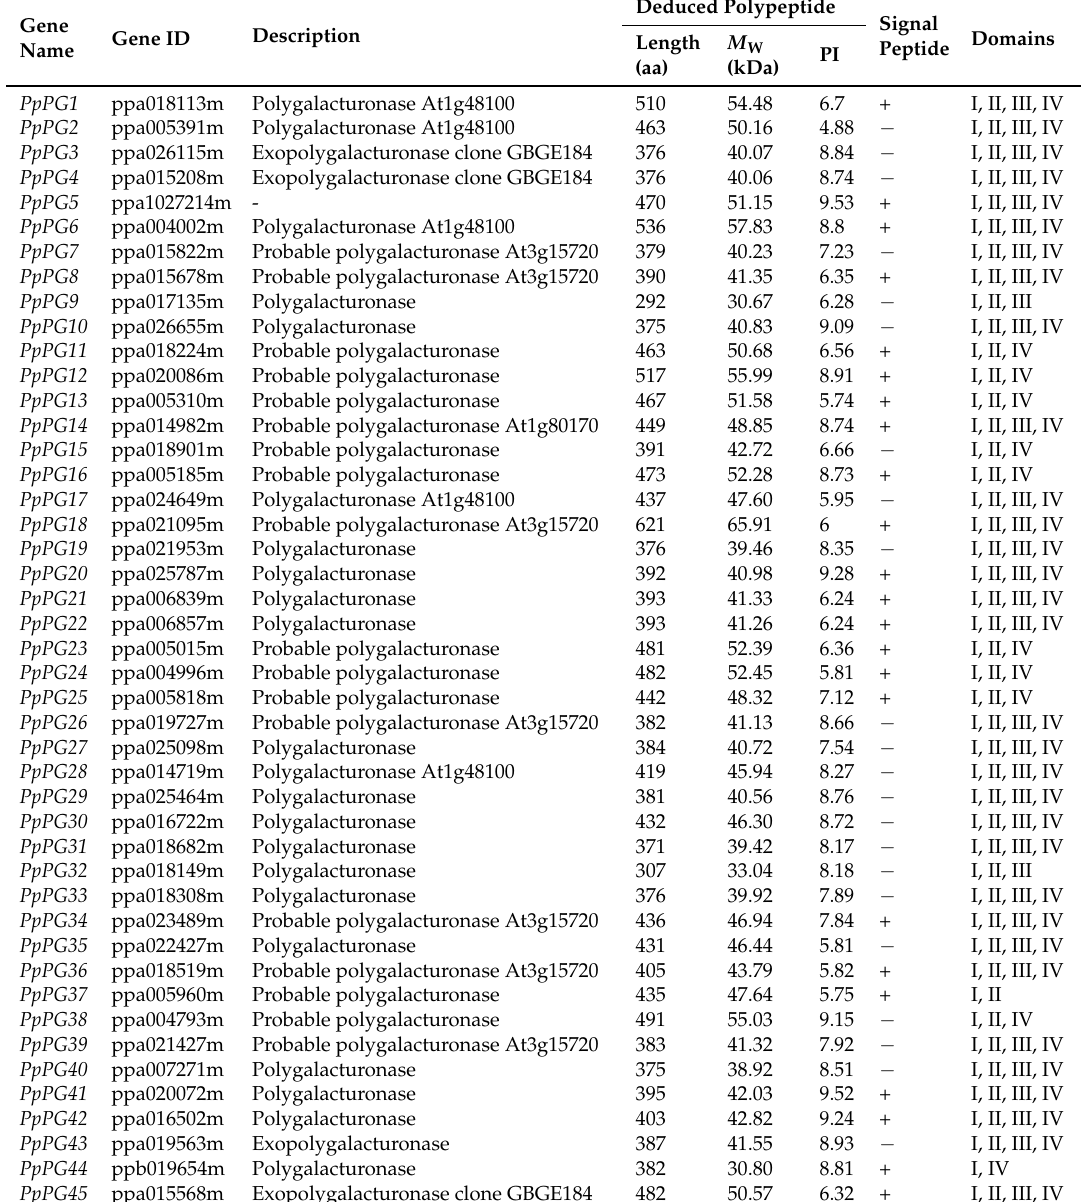
Table 1. Peach PG genes identified in this